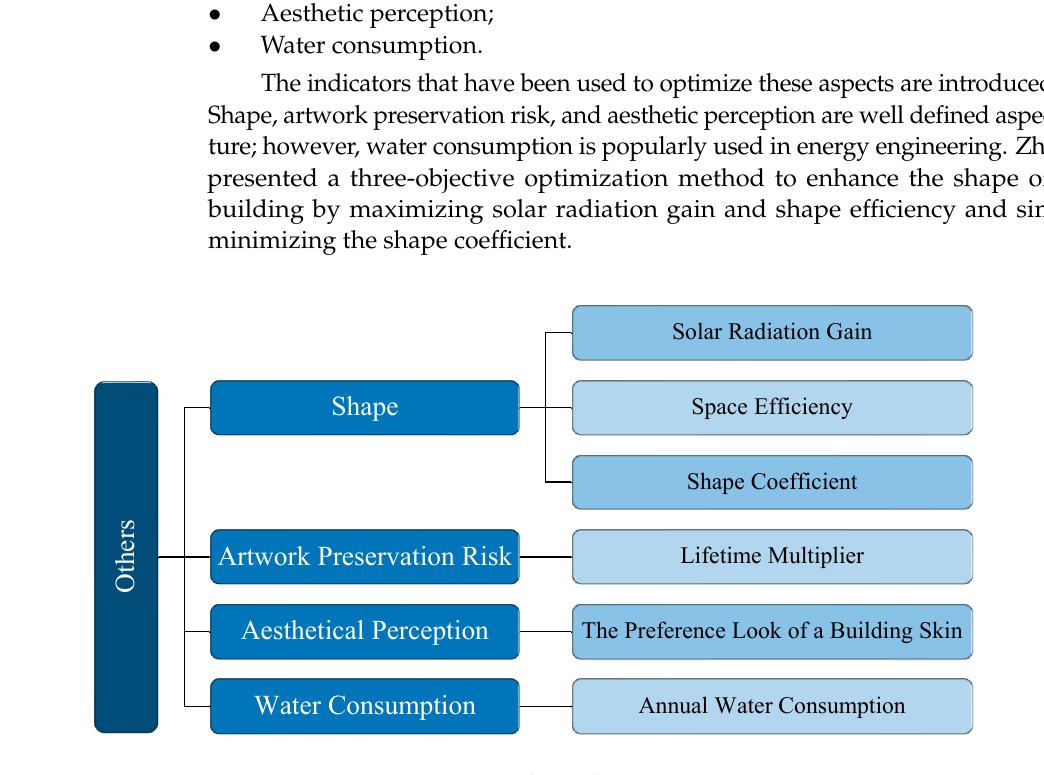
Figure 10. Other indicators.